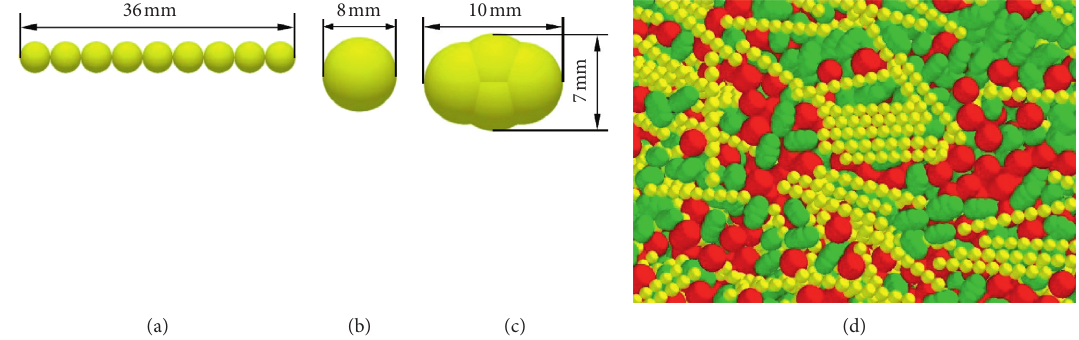
Figure 9: Discrete element model of material particles: (a) crop straw; (b) globular corn grain; (c) silage block; (d) partial view of material at a given